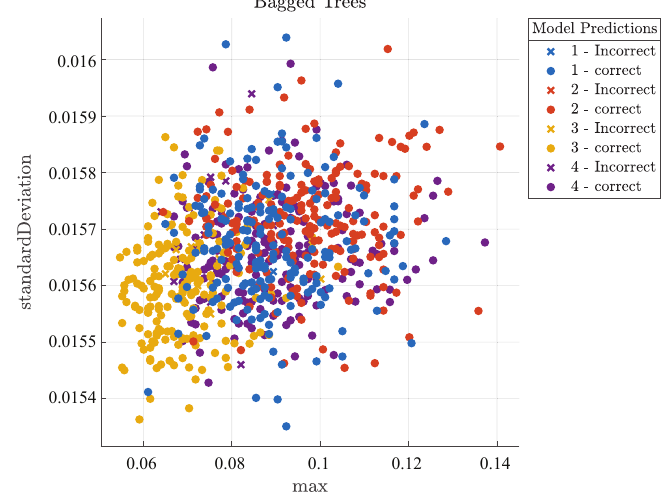
Figure 21. Scatter diagram of